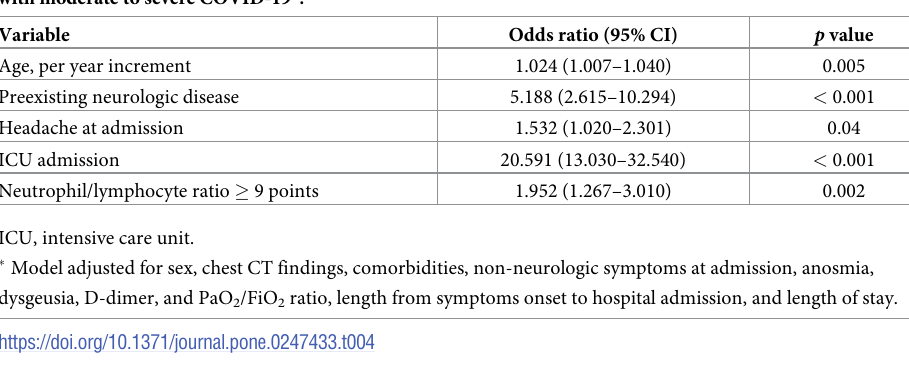
Table 4. Predictors for the development of new neurologic events during hospitalization in patients hospitalized with moderate to severe COVID-19 � .